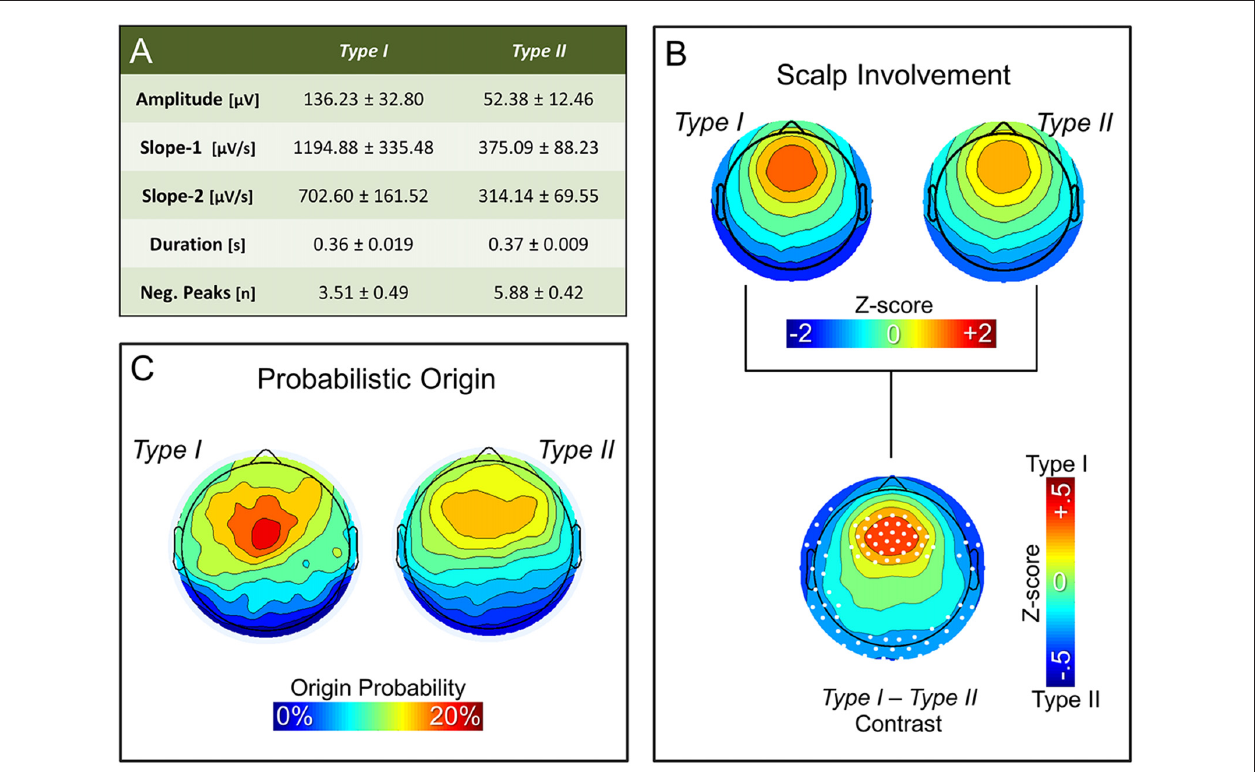
FIGURE 3 | Properties of non-REM (NREM) slow waves classified as type I and type II. Panel (A) displays the mean ± SD for the main morphological properties of slow waves detected during the first NREM cycle: amplitude, slope-1, slope-2, duration and number of negative peaks. Topographic plots in panel (B) represent the mean scalp involvement of type I and type II waves, as well as the statistical comparison between the two ( p < 0.05, Bonferroni corrected). Finally, topographic plots in panel (C) show the distribution of the probabilistic origin for the two types of slow